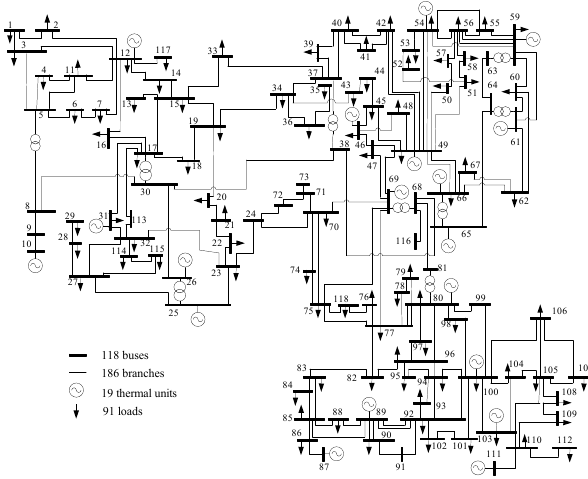
Figure 8. N = 118 topology of the power grid.